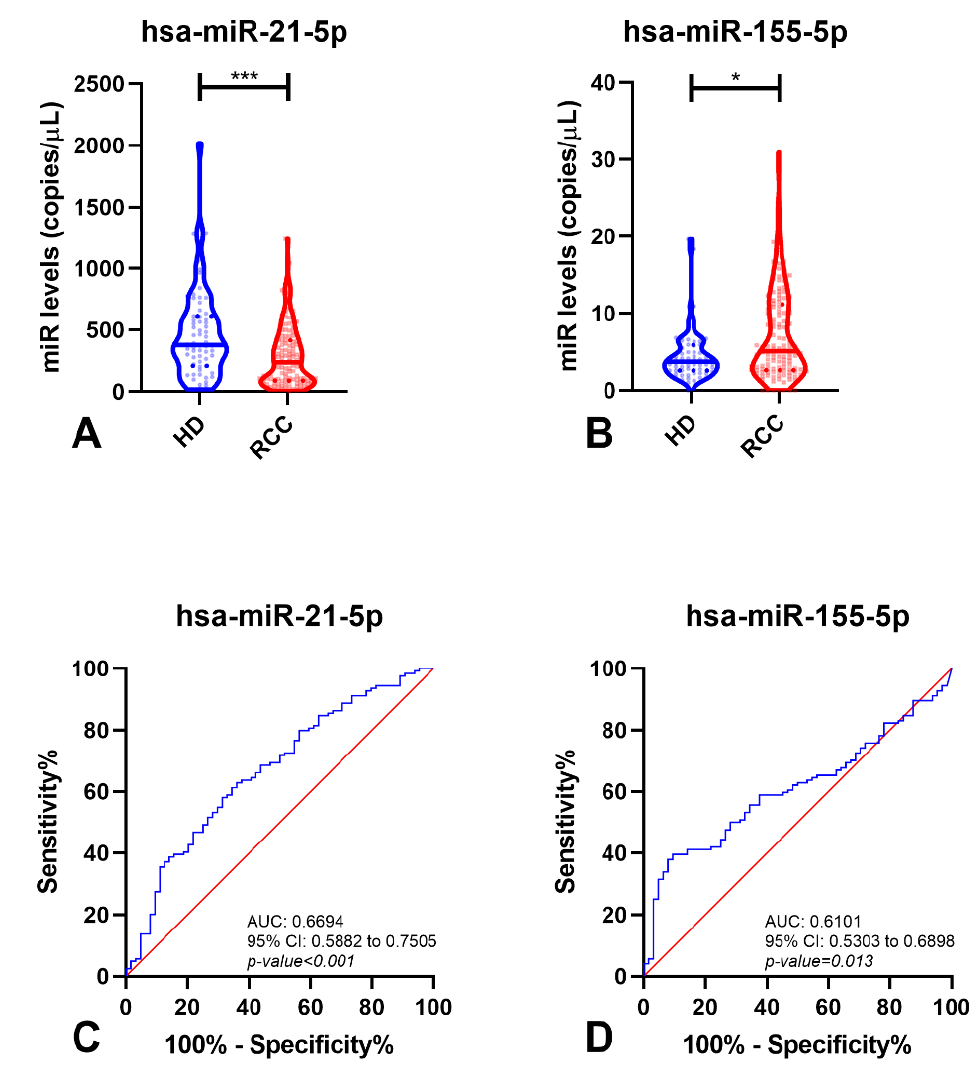
Figure 1. Violin plots with miRNA levels in Healthy Donors (HD) and Renal Cell Carcinoma (RCC) samples of hsa-miR-21-5p ( A ) and hsa-miR-155-5p ( B ), and respective Receiver-Operating Characteristic Curve (without resampling analysis) ( C , D ). In violin plots, dashed lines indicate the interquartile range and horizontal line the median of miR levels. In ROC curves, red line indicates the reference line and blue line the identity line for each miRNA. Abbreviations: AUC—Area Under the Curve; CI—Confidence Interval, HD—Healthy Donors, RCC—Renal Cell Carcinoma, * — p -value < 0.05, *** — p -value < 0.0001. Table 2. Performance of miRNAs as biomarkers for detection of Renal Cell Carcinoma. miRNAs